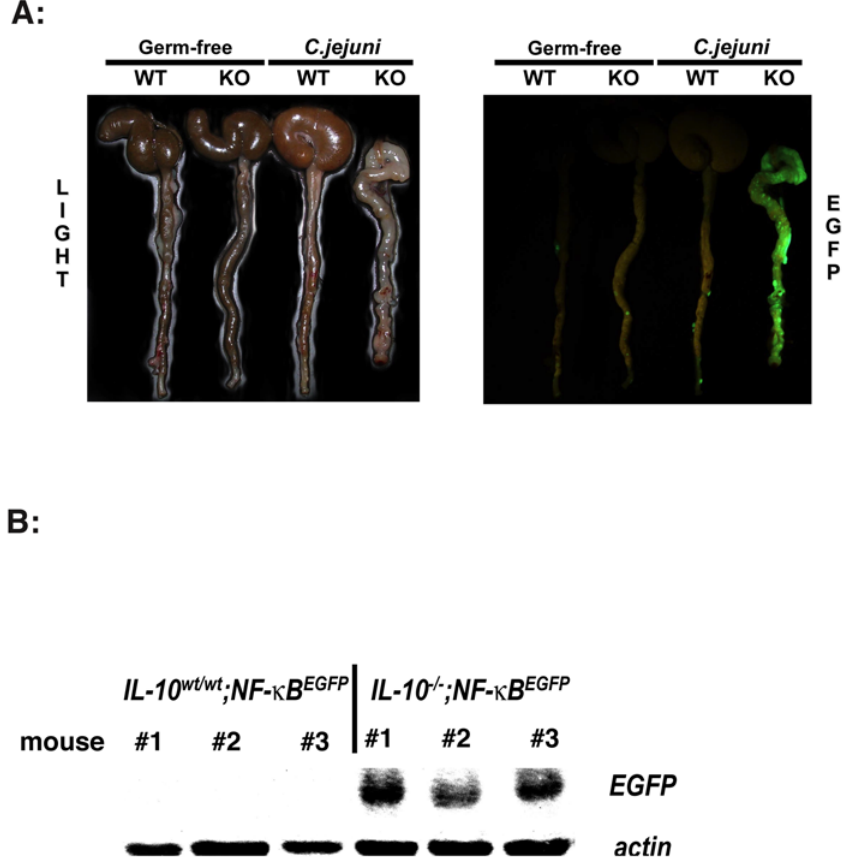
Figure 5. C.jejuni induces NF- k B signaling in IL-10 2 / 2 ; NF- k B EGFP mice. (A) C. jejuni induces NF- k B activity in the colon of IL-10 2 / 2 ; NF- k B EGFP mice. IL-10 wt/wt ; NF- k B EGFP and IL-10 2 / 2 ; NF- k B EGFP mice were colonized for 14 days with C. jejuni (10 8 cfu/mouse), mice were euthanized, colons dissected and EGFP expression immediately visualized using a CCD camera in a light-tight imaging box with a dual filtered light source. The data are representative of three independent experiments. IL-10 wt/wt ; NF- k B EGFP : n=8, IL-10 2 / 2 ; NF- k B EGFP : n=4, IL-10 wt/wt ; NF- k B EGFP C. jejuni associated: n=13, IL-10 2 / 2 ; NF- k B EGFP C. jejuni associated: n=12. (B) C. jejuni induces elevated EGFP protein expression in the colon. Colonic protein of C. jejuni associated IL-10 wt/wt ; NF- k B EGFP and IL-10 2 / 2 ; NF- k B EGFP were extracted and 20 m g were used for SDS-PAGE gel analysis. Gels were stained with EGFP specific antibodies. n=3 per group.